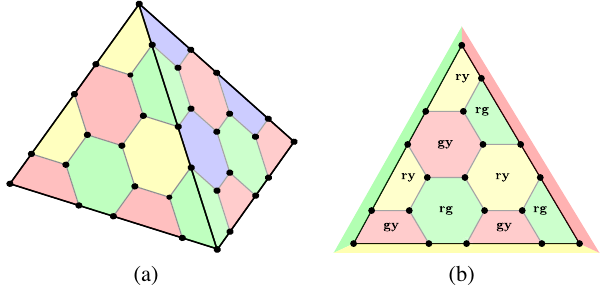
FIG. 14. (a) The tetrahedral 3-colex. (b) The b boundary of the tetrahedral lattice consists of faces that are colored uv with u , v ≠ b , which are then relabeled according to gy ↔ A , ry ↔ B , and rg ↔ C